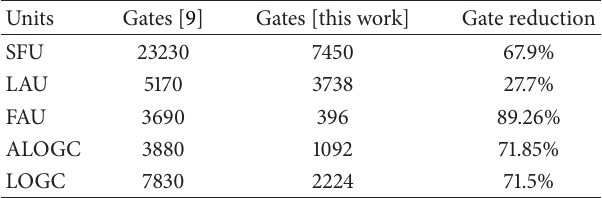
Table 9: Comparison of results in terms of area.